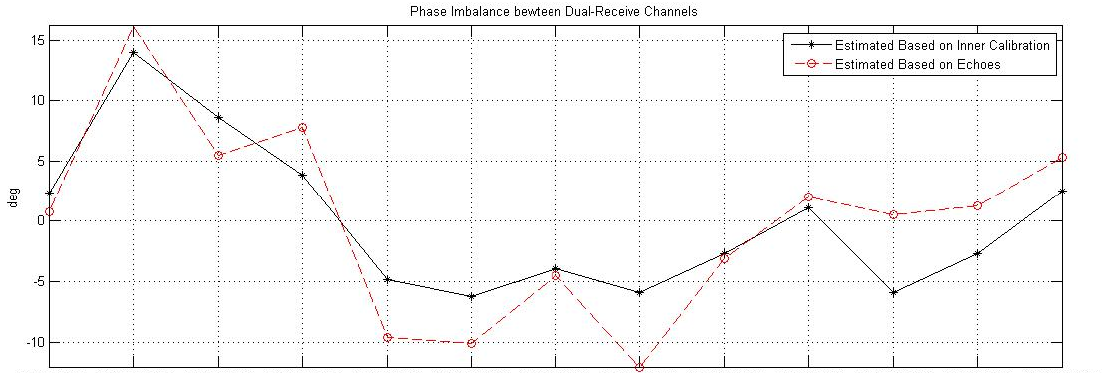
Figure 9. The amplitude and phase imbalance between dual-receive channels of ultra-fine stripmap mode of GF-3 monitored at the commissioning phase.